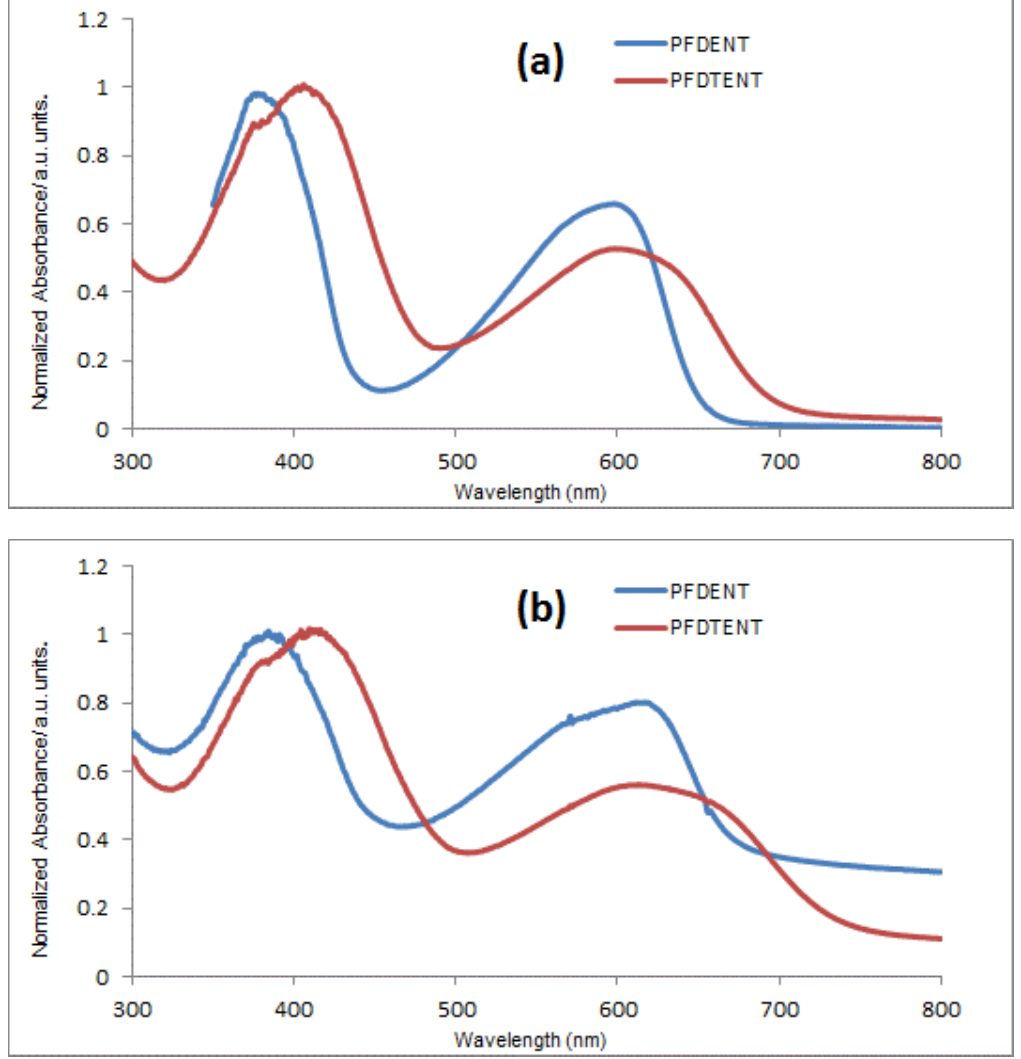
Figure 2. ( a ) Normalized absorption spectra of polymers in chloroform solution, ( b ) Absorption spectra of polymers as thin films.